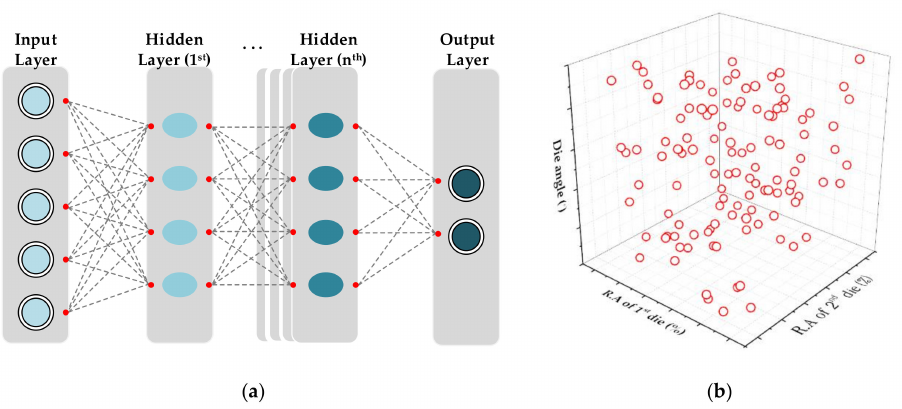
Figure 9. Schematic diagram of sampling method and neural network: ( a ) Deep Neural Network (DNN); ( b ) Latin Hypercube Sampling